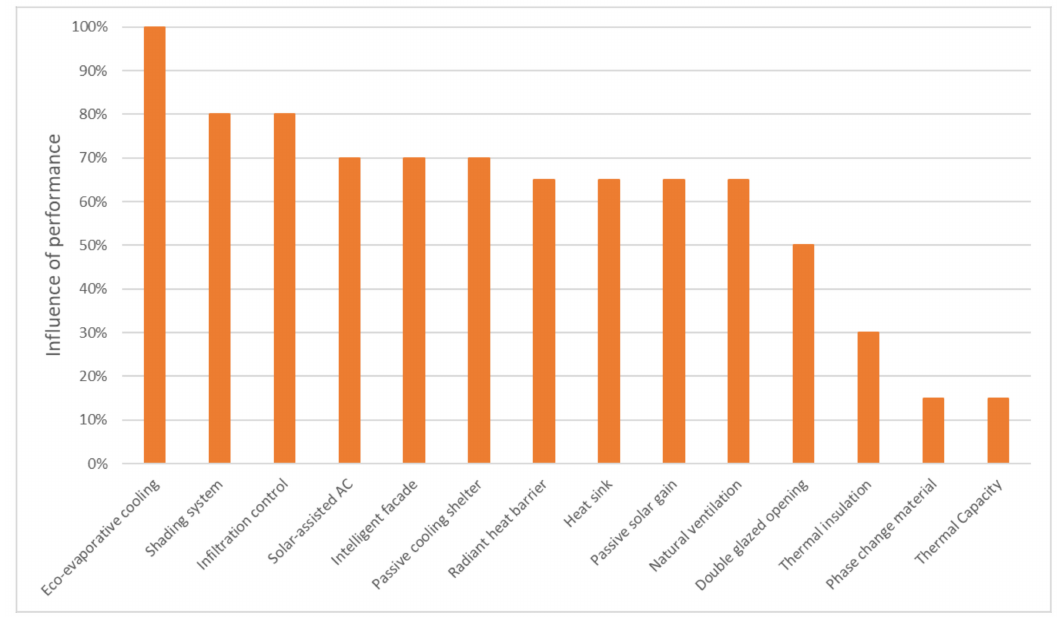
Figure 3. Influence of performance of the passive